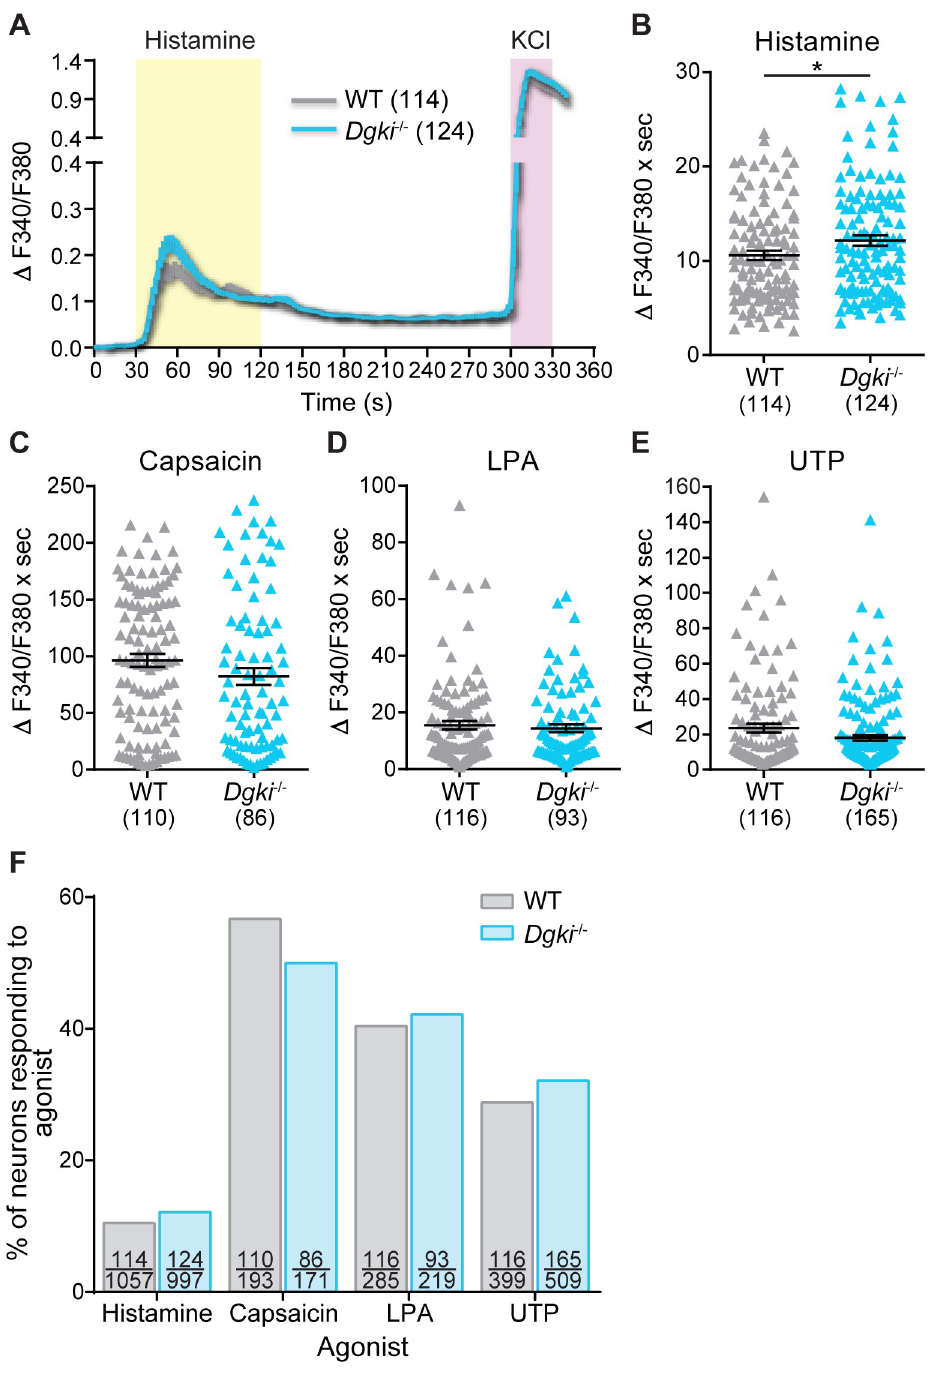
Fig 5. In vitro calcium responses to histamine, but not algogenic agonists, are enhanced in Dgki -/- mouse DRG neurons. Calcium activity of DRG neurons dissected and cultured from WT and Dgki -/- mice in response to 100 μ M histamine (A,B), 1 μ M capsaicin (C), 10 μ M lysophosphatidic acid (LPA; D), or 100 μ M uridine triphosphate (UTP; E). Each experiment ended with exposure to 100 mM KCl to ensure neuron health. Average calcium responses over time in WT and Dgki -/- DRG neurons are shown for histamine experiments in (A). The area under the curve representing the 90 s of agonist exposure was calculated for each responding neuron, plotted in (B-E). F) The proportion of all healthy neurons (neurons respond to KCl) responding to the indicated agonists. For (A-E) the number of responding neurons is indicated in parentheses, and graphs show mean ± SEM. For (F) on each bar the top number indicates the number of neurons responding to the agonist and the bottom number indicates the total number of healthy neurons.